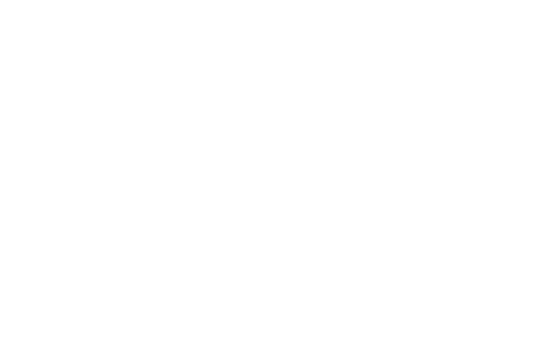
Table 2. The number of generated matrices.